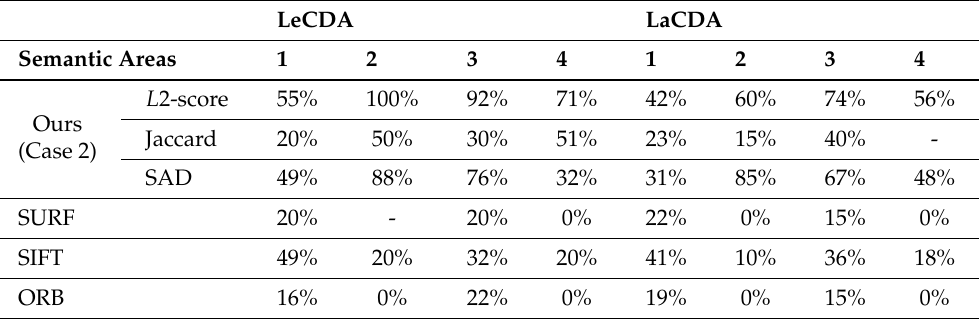
Table 2. Comparative accuracy (%) results of clustered ground-truth images in each semantic area for different experimental set-ups. Table entries marked with ”-” correspond to communities that are not detected. Throughout, 0% performance indicates communities that are included but not recognised according to the ground-truth. The higher performance rates are represented in